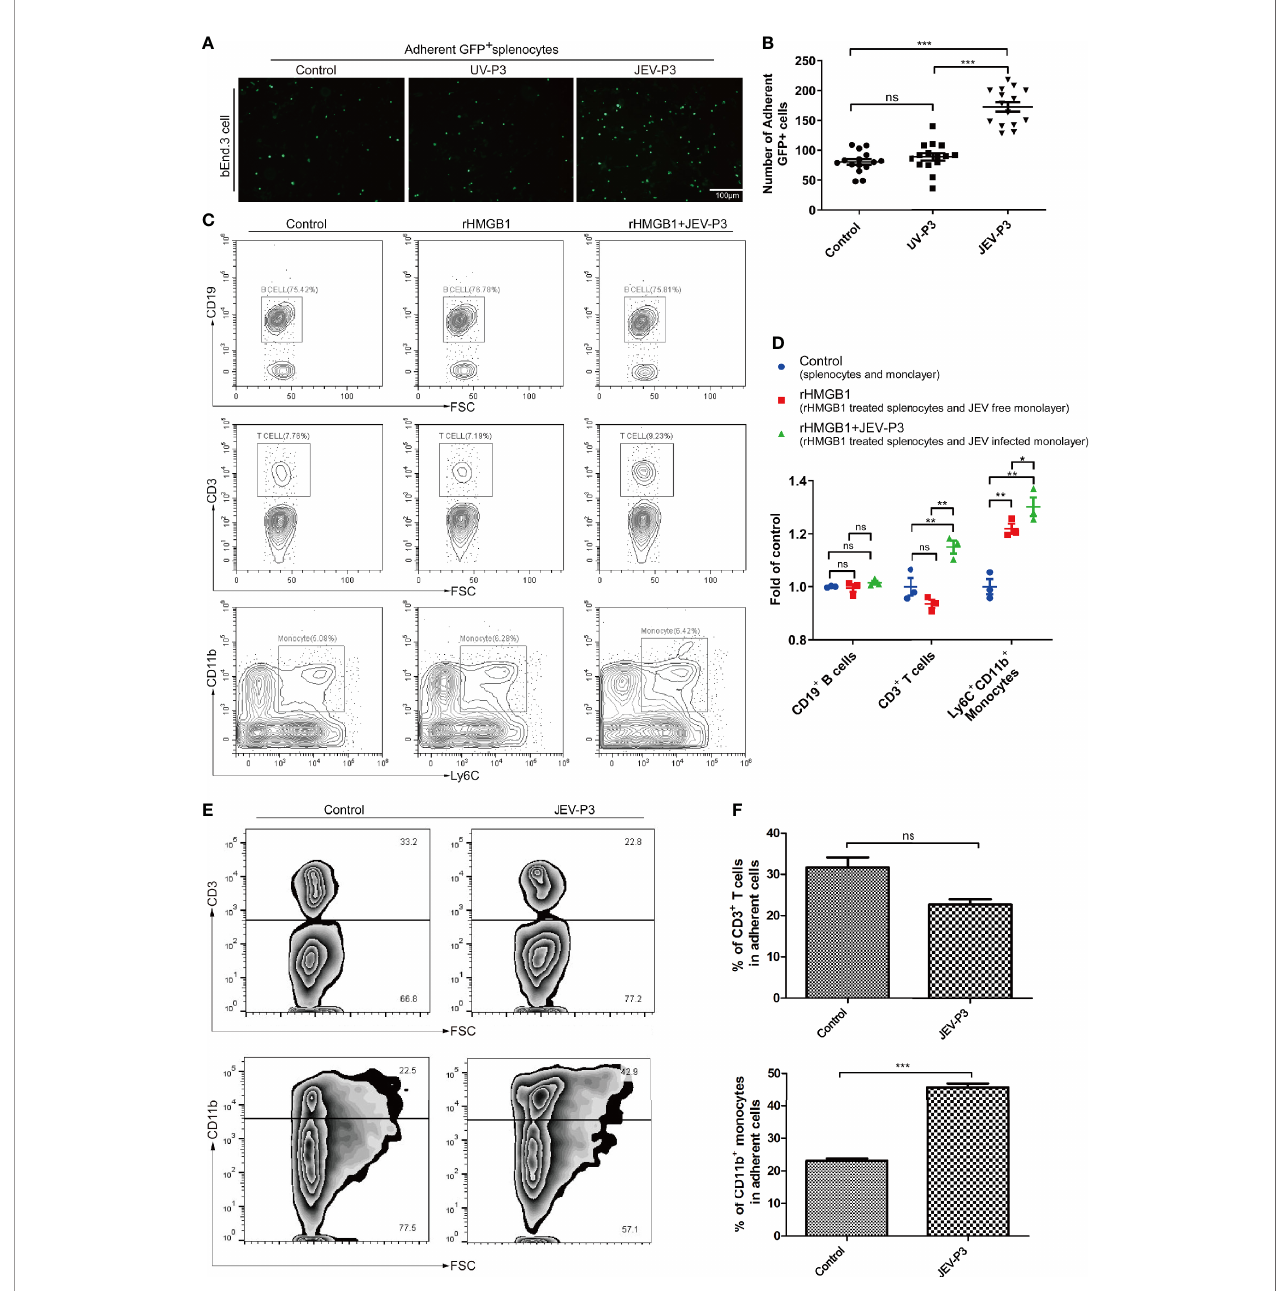
FIGURE 3 | HMGB1 promoted immune cell adhesion to the BMEC monolayer. (A) GFP+ splenocytes were incubated with JEV-P3/UV-P3-infected bEnd.3 cell monolayers for 2 h; the GFP+ splenocytes were obtained from transgenic mice. After washing with PBS, the cells were fi xed with 4% paraformaldehyde and then observed by fl uorescence microscopy. The fl uorescence represents the number of adherent splenocytes. JEV free monolayers were served as control. (B) Statistical analysis of the GFP+ splenocytes binding to the bEnd.3 cell monolayer of (A) . (C) Mouse splenocytes were treated with rHMGB1 (100 ng/ml) for 2 h. Then, splenocytes (rHMGB1 treated or untreated) were incubated with the bEnd.3 cell monolayers (JEV infected or uninfected) for 2 h. After gentle washing with PBS, the adherent splenocytes were collected, and the amount of CD19+ B cells, CD3+ T cells, and Ly6C+CD11b+ monocytes was analyzed by fl ow cytometry. Untreated splenocytes and uninfected monolayers were served as control. (D) Statistical analysis of the binding splenocytes to the bEnd.3 cell monolayer as reported in (C) . (E) Puri fi ed CD3+ T cells and CD11b monocytes [obtained from JEV-infected mice, tail vein injection (F) , 3 dpi] were inoculated onto the virus-infected bEnd.3 cell monolayer and incubated for 2 h. After washing with PBS, the bound cells were detected by fl ow cytometry. The right panels show the results of the statistical analysis of CD3+ T cells and CD11b monocytes binding to the bEnd.3 cell monolayer of (F) . JEV free bEnd.3 cell monolayers were served as control. The scale bar for (A) is 100 mm. These experiments were repeated at least three times. The data are expressed as the means ± SEM. p > 0.05 (ns, no signi fi cant difference), *p < 0.05, **p < 0.01, and ***p <